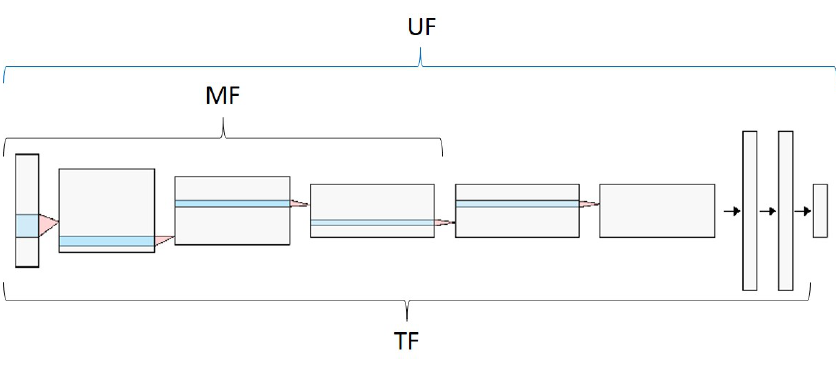
Figure 9. Transfer learning options. UF (not frozen weights), MF (medium freezing point), TF (totally frozen, except for the last fully connected (FC) layer). The image was generated using NN-SVG